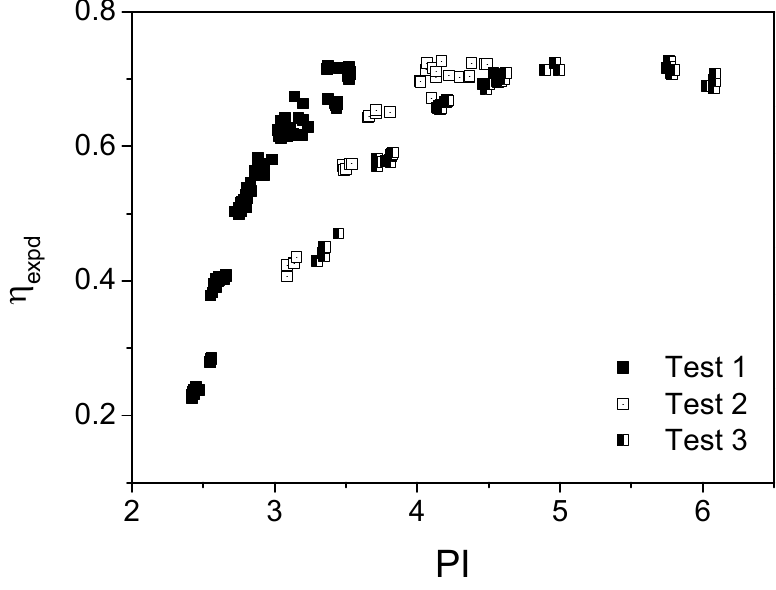
Figure 7. Test results of effects of PI and supply pressure on expander isentropic